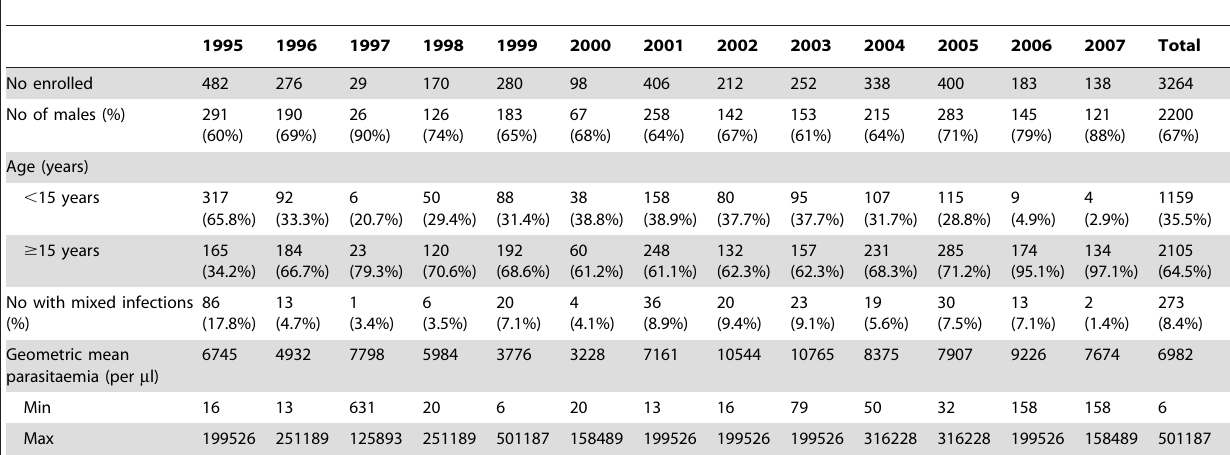
Table 2. Demographic characteristics on admission of patients enrolled in antimalarial drug efficacy trials who received MAS 3 , between 1995 and